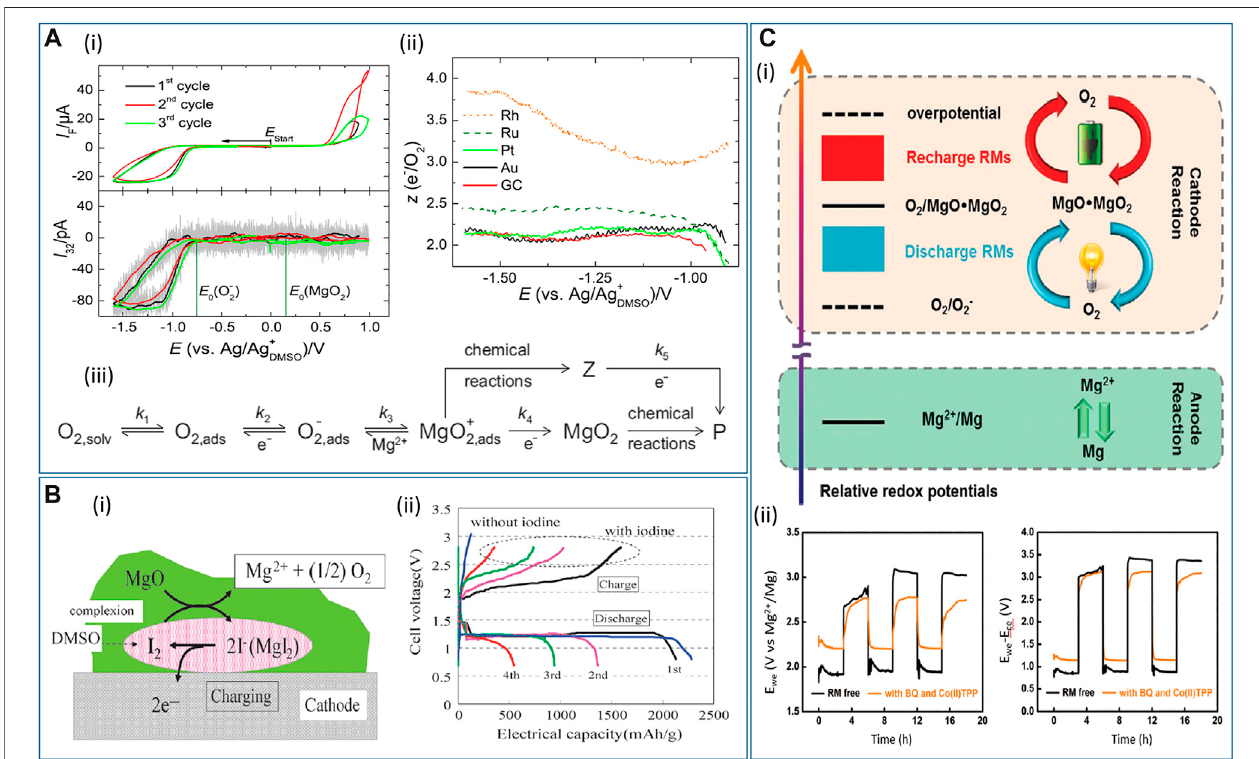
FIGURE 5 | (A-i) Subsequent CVs at 10 mV s − 1 and corresponding mass spectrometric CVs for O 2 in 0.4 M Mg[ClO 4 ] 2 /DMSO saturated with a mixture of Ar and O 2 (80:20)onPt. (A-ii) Numberofelectronsztransferredperoxygenmoleculeondifferentelectrodematerialsin0.4 M Mg[ClO 4 ] 2 /DMSOwith20%O 2 saturation. (A-iii) Proposed ORR mechanism on Pt in Mg 2+ -containing DMSO electrolyte with k i being the rate constant of step i , P being the unknown fi nal products, and Z being an intermediate.Reproducedwithpermissionfrom(Reinsbergetal.,2016a). (B-i) ProposedreactionmechanismofthechargingprocessforMg-O 2 cellusingI 2 asthe redox mediator. (B-ii) Discharge-charge curves of Mg-O 2 cell with I 2 at 60 ° C. Reproduced with permission from (Shiga et al., 2013). (C-i) Operation principles of systems with dual redox mediators. (C-ii) Galvanostatic cyclingof Mg-O 2 cell using 1,4-benzoquinone and 5,10,15,20-tetraphenyl-21H,23H-porphine cobalt(II) asdual redoxmediators.Theleftpanelshowsthevoltagepro fi lemeasured againsttheMgreferenceelectrodeinathree-electrodecon fi guration, whereastherightpanelshows the voltage pro fi le against the counter electrode in a two-electrode con fi guration. Reproduced with permission from (Dong et al., 2016).